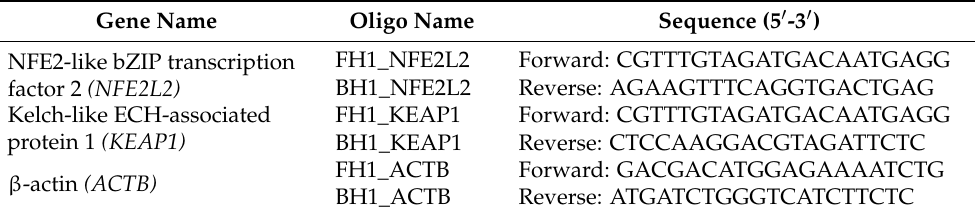
Table 1. Characteristics of the primers that were used in the